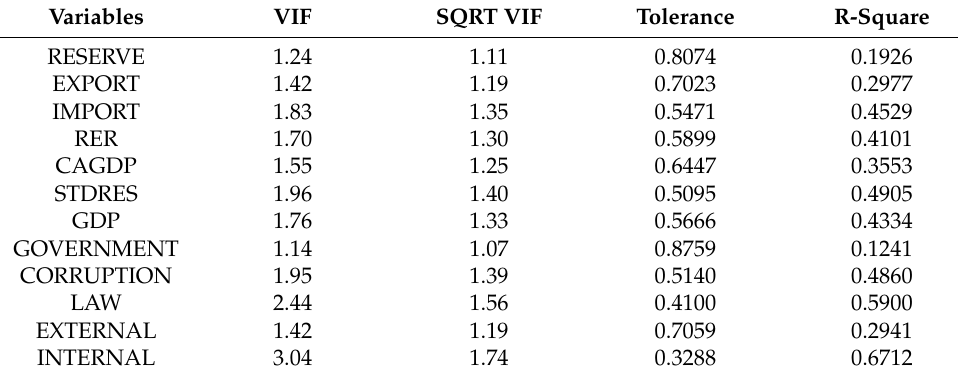
Table 2. Multicollinearity between explanatory